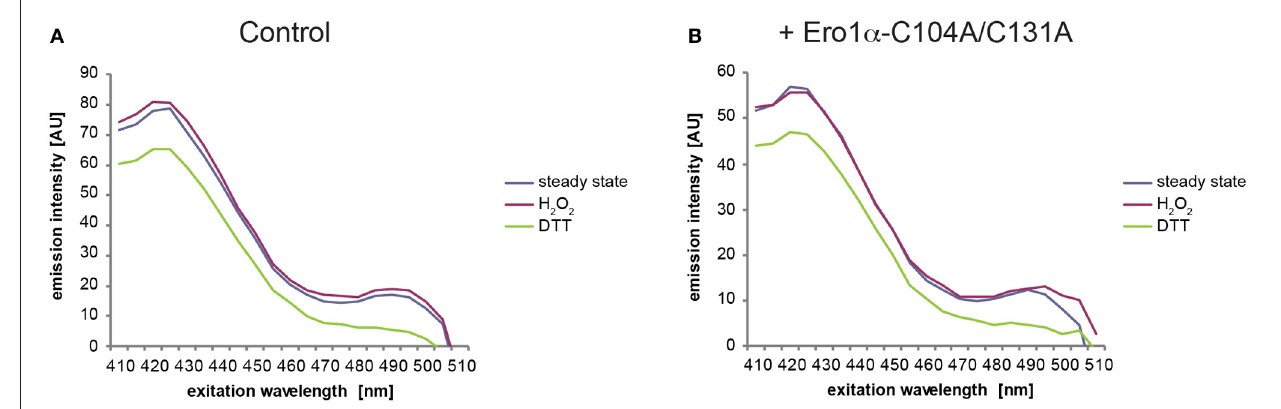
FIGURE 7 | DTT treatment changes the fluorescence excitation spectrum of SypHer ER . Fluorescence excitation spectra were recorded from uninduced (A) or induced (B) FlipIn TRex 293:Ero1 α -C104A/C131A